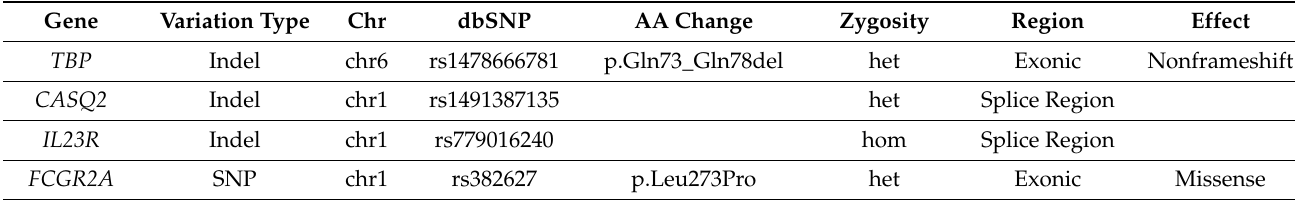
Table 1. List of genes presenting variants (SNPs and indels) only in tumor at diagnosis.